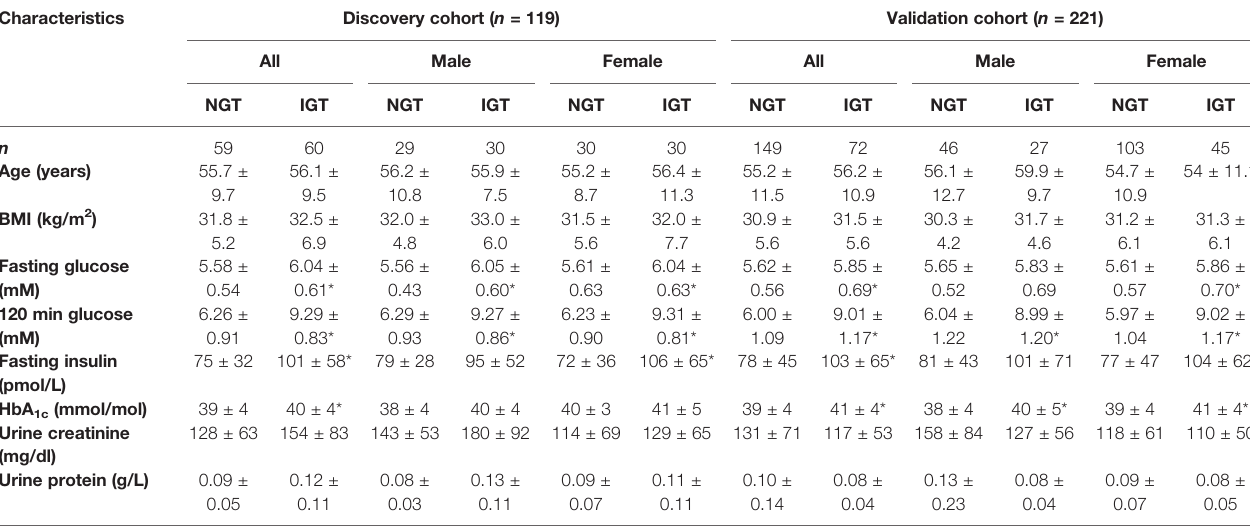
TABLE 1 | Anthropometric and clinical characteristics of normal glucose-tolerant (NGT) and impaired glucose-tolerant (IGT) individuals of the cohorts of the study. Characteristics Discovery cohort ( n =